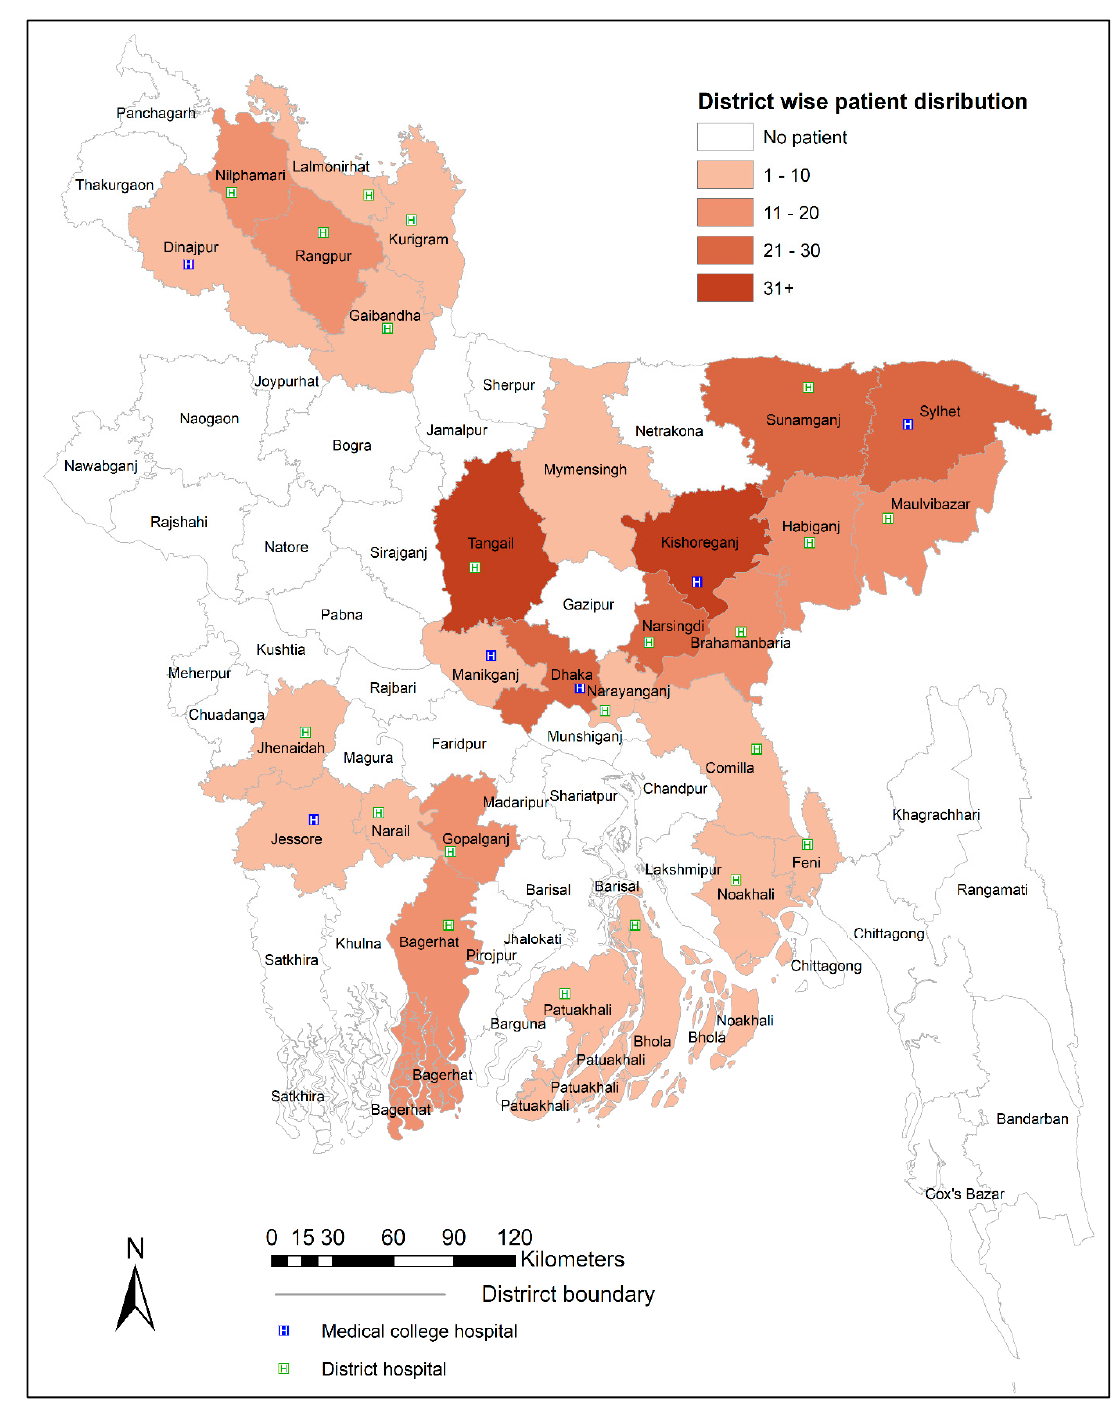
Figure 1. The map of Bangladesh depicting the studied locations.